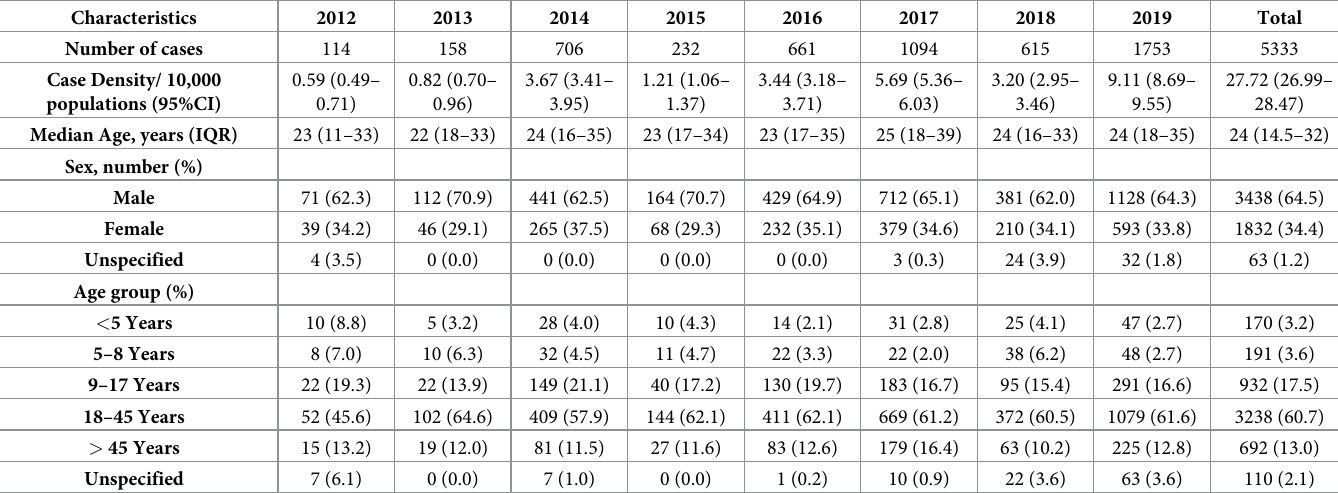
Table 1. Demographic characteristics of notified dengue cases in Bhopal city (2012–2019).